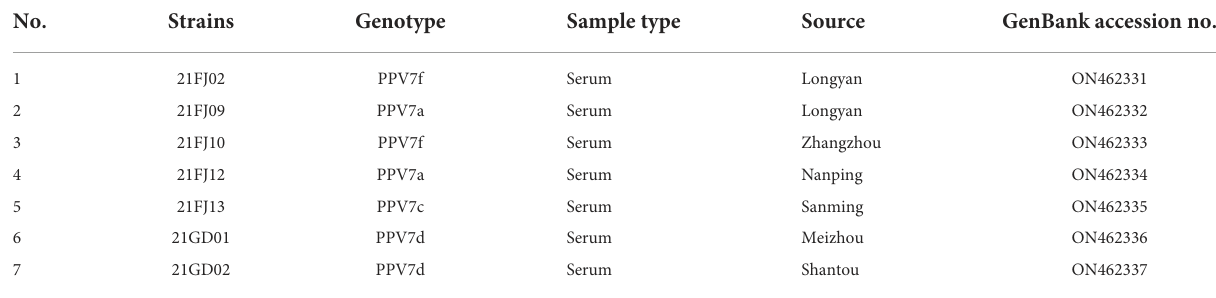
TABLE 2 The PPV7 strains identified in this study. No. Strains Genotype Source GenBank accession